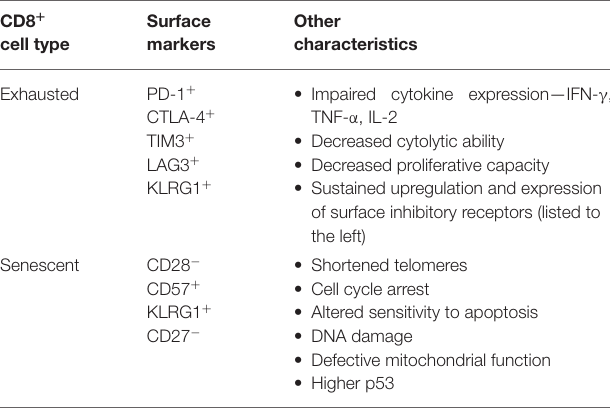
TABLE 1 | Typical surface markers and established characteristics of exhausted and senescent CD8 + T cells. CD8